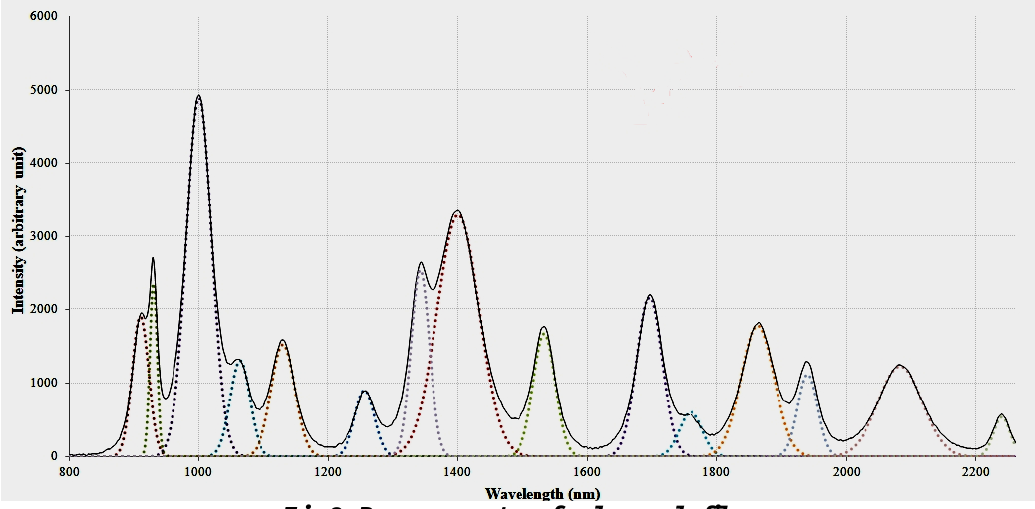
Fig.8: Raman spectra of polypyrrole